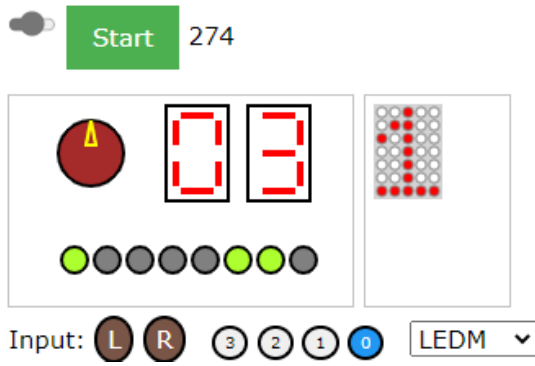
Figure 4. Board simulator in the SHDL tool.